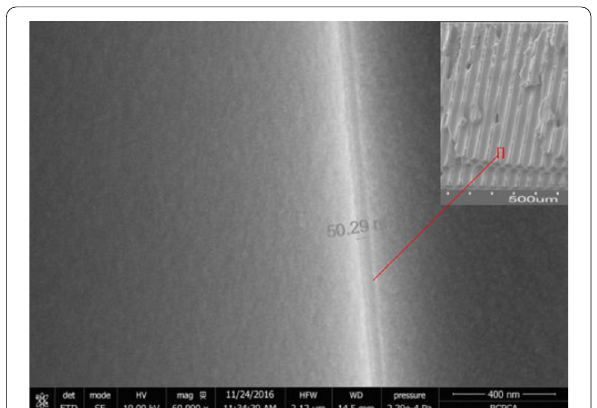
Fig. 6 Cross-sectional SEM picture of the